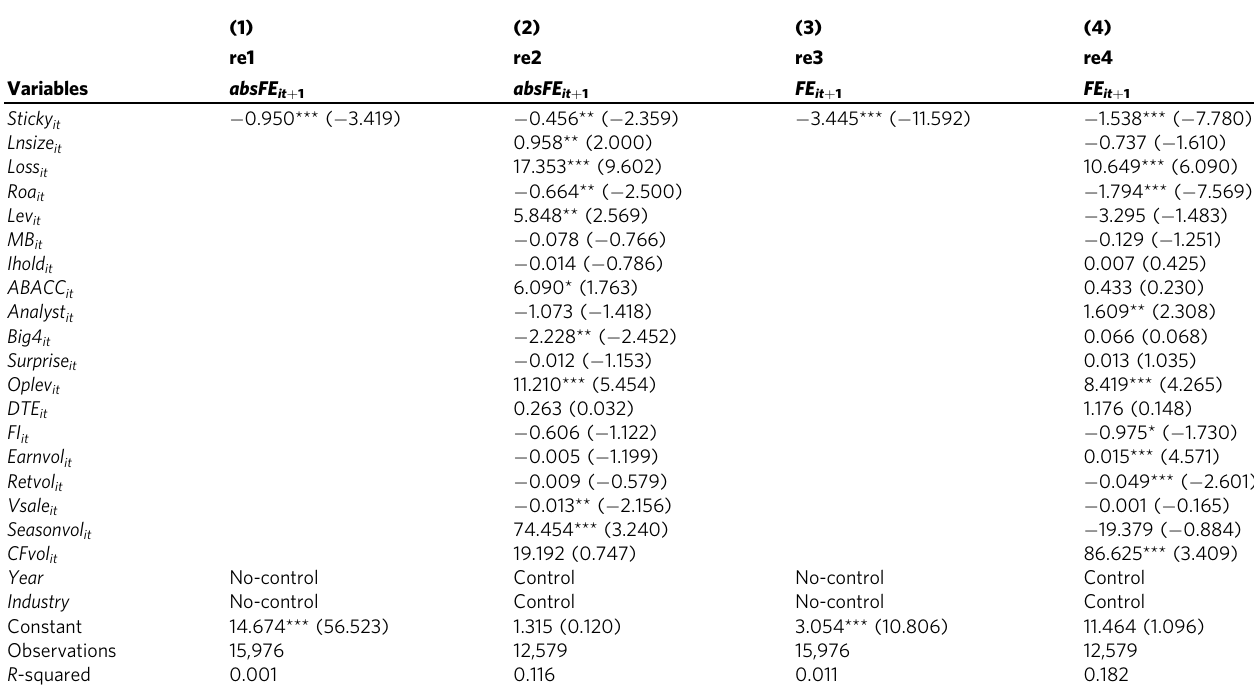
Table 6 Regression results of analysts ’ forecast accuracy on cost